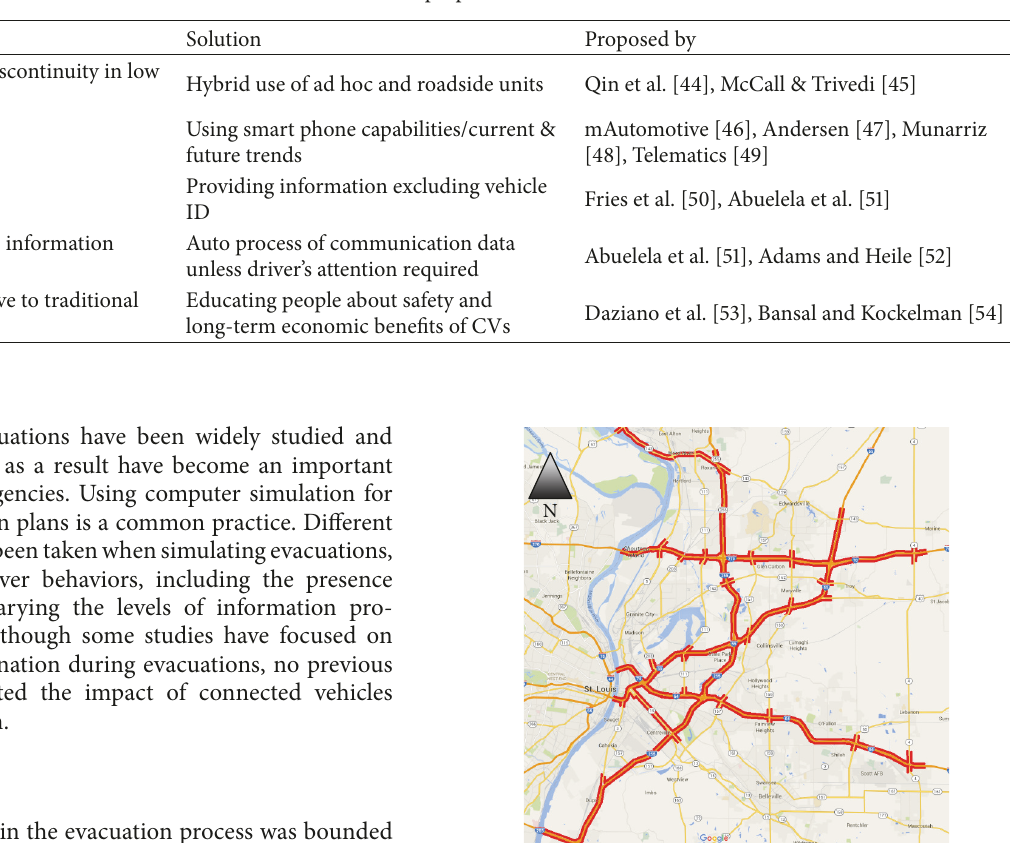
Table 3: Identified issues and proposed solutions for CVs.